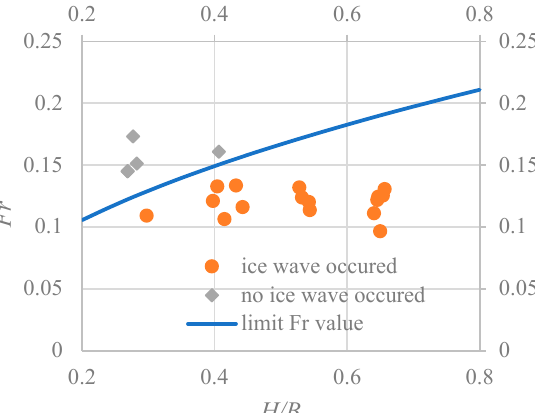
Figure 7. Calculated limiting flow Froude number Fr for developing an ice wave compared to those of laboratory experiments.